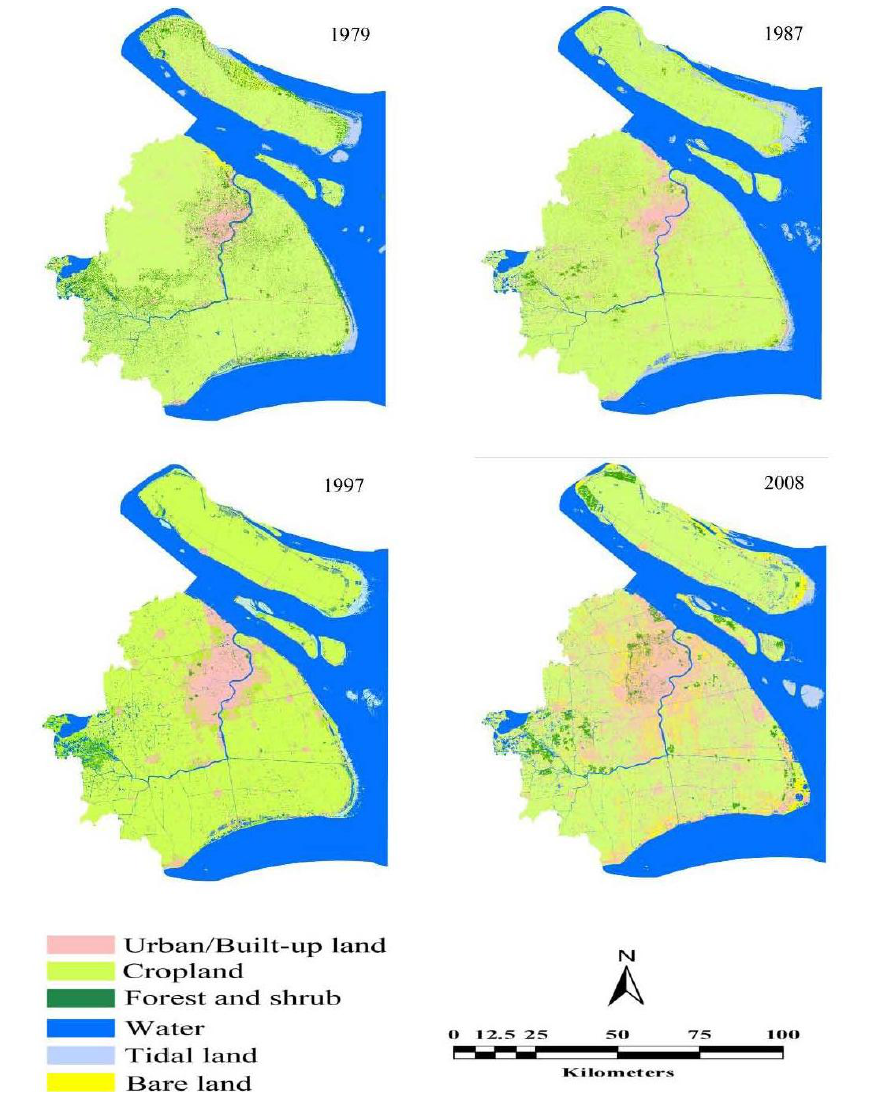
Figure 2. Land use maps of the study area in